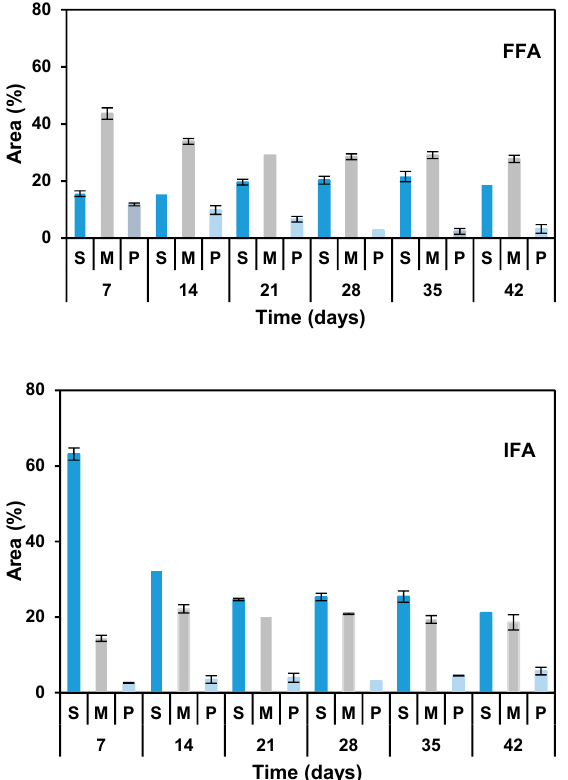
Figure 5. Aldehyde content (area %, mean value ± SD) in FFA and IFA series during the thermal treatment. S, saturated; M, monounsaturated; P, polyunsaturated.